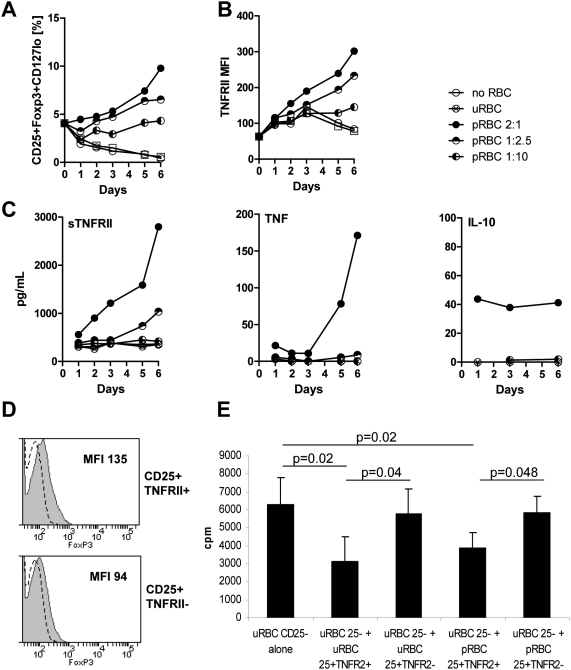
In vitro P. falciparum exposure induced Treg cell expansion, TNFRII expression, and enhanced Treg cell activity.PBMC from healthy malaria-unexposed blood donors (n = 4) were cultured overnight in the presence of P. falciparum–infected red blood cells (pRBC) at pRBC∶PBMC ratios of 2∶1, 1∶2.5, and 1∶10, or uninfected red blood cells (uRBC) at a uRBC∶PBMC ratio of 2∶1 or without RBC. (A) CD4+CD25+Foxp3+CD127lo Treg cells are represented as percentage of CD4 T cells. (B) TNFRII MFI on CD4+ Foxp3+CD127lo Treg cells. (C) sTNFRII (left panel), TNF (middle panel), and IL-10 (right panel) concentration in culture supernatants. (D) Following overnight culture with P. falciparum–infected red blood cells (pRBC) or uninfected red blood cells (uRBC) at a RBC∶PBMC ratio of 1∶2.5, PBMC were sorted into CD4+CD25− responder cells and CD4+CD25+TNFRII+ or CD4+CD25+TNFRII− Tregs and stained intracellularly for Foxp3. Foxp3 expression is shown for CD4+CD25+TNFRII+ or CD4+CD25+TNFRII− Treg cells (grey line) and CD4+CD25− responder cells (dotted line). (E) Sorted cells were tested for suppressive activity. 104 CD4+CD25− responder T cells sorted after uRBC exposure were incubated either alone or with TNFRII+ or TNFRII− Tregs after uRBC or pRBC exposure at a 1∶1 ratio in 96 well plates pre-coated with 3 µg/mL anti-CD3 antibody (OKT-3) for 3 days. Sorted monocytes were used as APC. Bars show mean cpm+/−SD of triplicate wells.